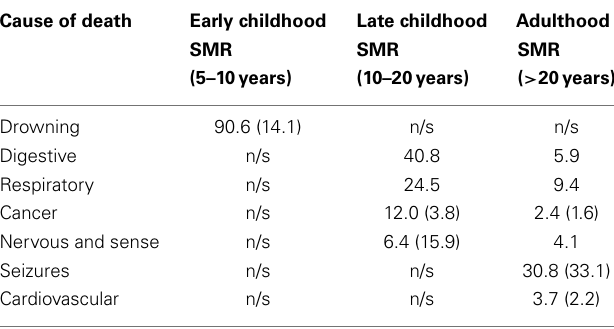
Table 1 | Causes of death inASD with moderate to severe retardation or none to mild retardation (in